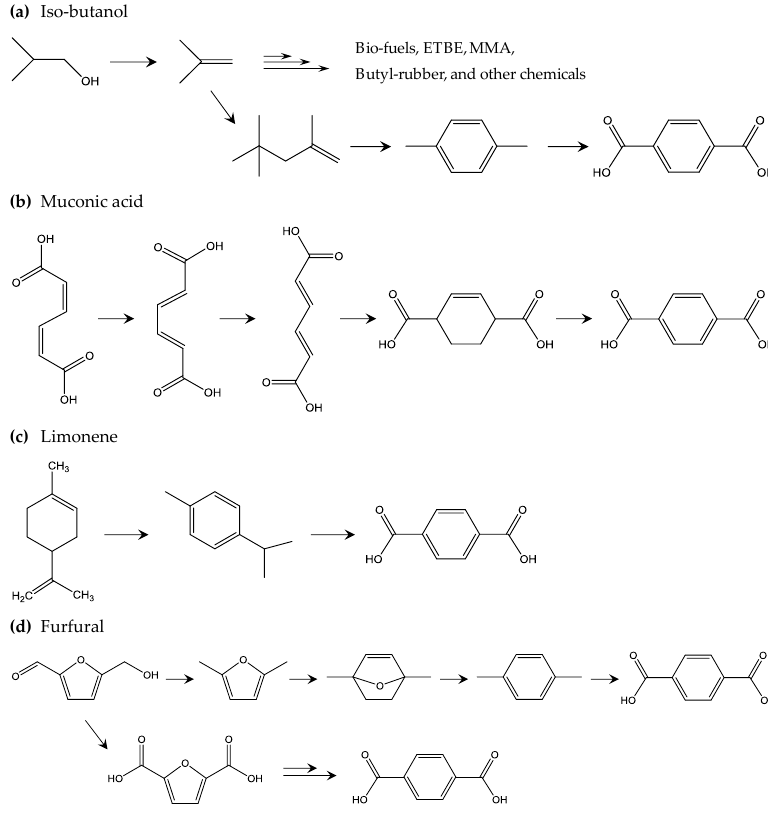
Figure 6. Proposed methods to achieve biobased TPA: ( a ) the iso -butanol method [67]; ( b ) the muconic acid method [68]; ( c ) the limonene method [69]; and ( d ) the furfural method [70–73].